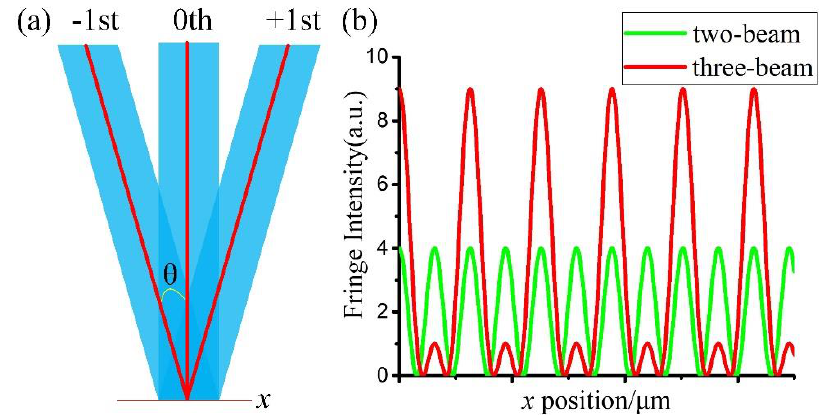
Figure 1. ( a ) Schematic diagram of three diffraction beams illumination on the sample plane. ( b ) The excitation intensity distributions along the x direction on the sample plane by two-beam (green) and three-beam (red) interference, assuming that the intensities of 0th and ± 1st order diffraction beams are identical. The larger the incident angle, the denser the fringes on the sample plane.